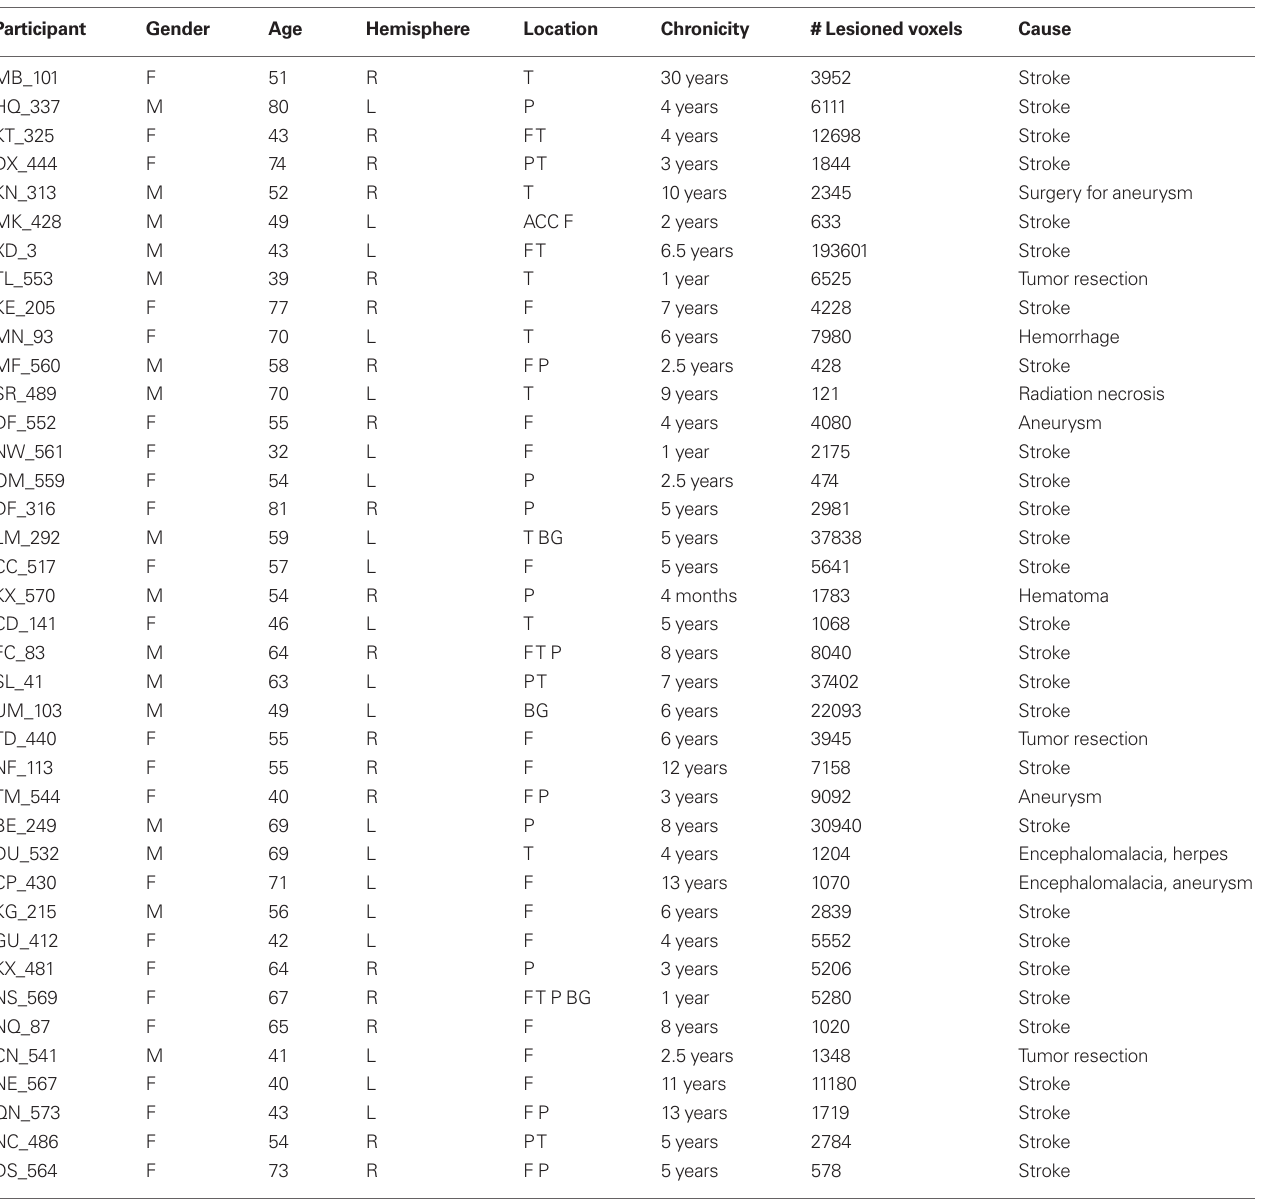
Table 1 | Participant demographic